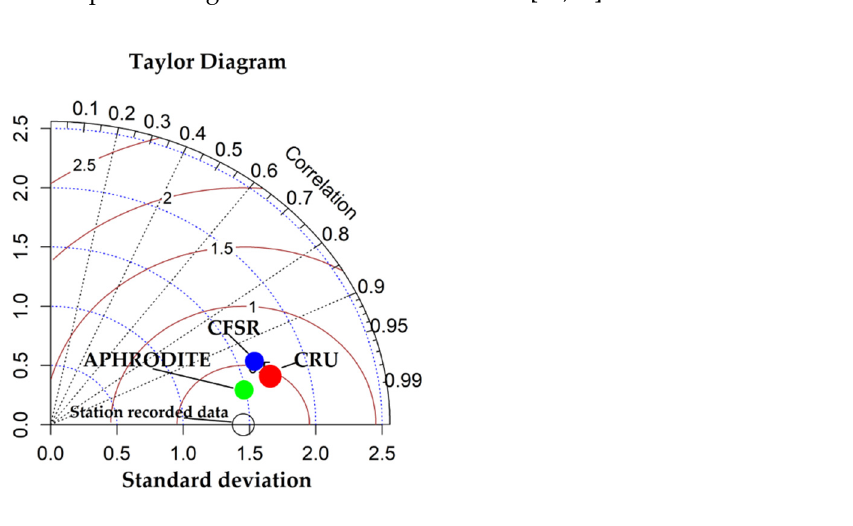
Figure 4. Taylor diagram indicating the performances of CRU, CFSR and APHRODITE precipitation data on a monthly scale at the Lakhsh climate station in the Upper Vakhsh River Basin in Central Asia.